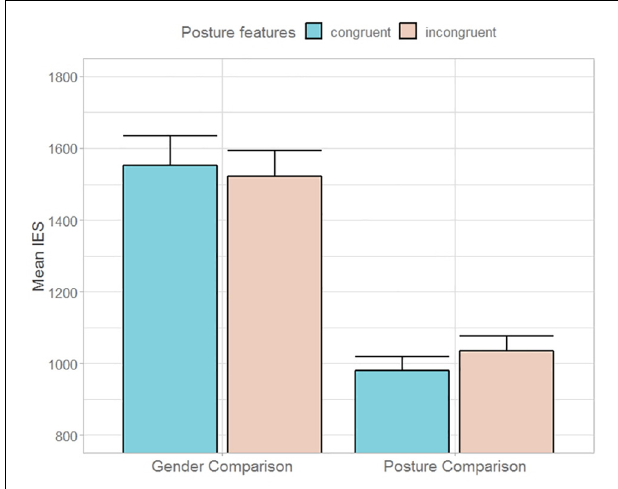
FIGURE 5 | Mean inverse efficiency scores (IES) during Gender and Posture comparison according to task-irrelevant postural congruency between central and lateral stimuli in Experiment 3. Error bars represent + 1